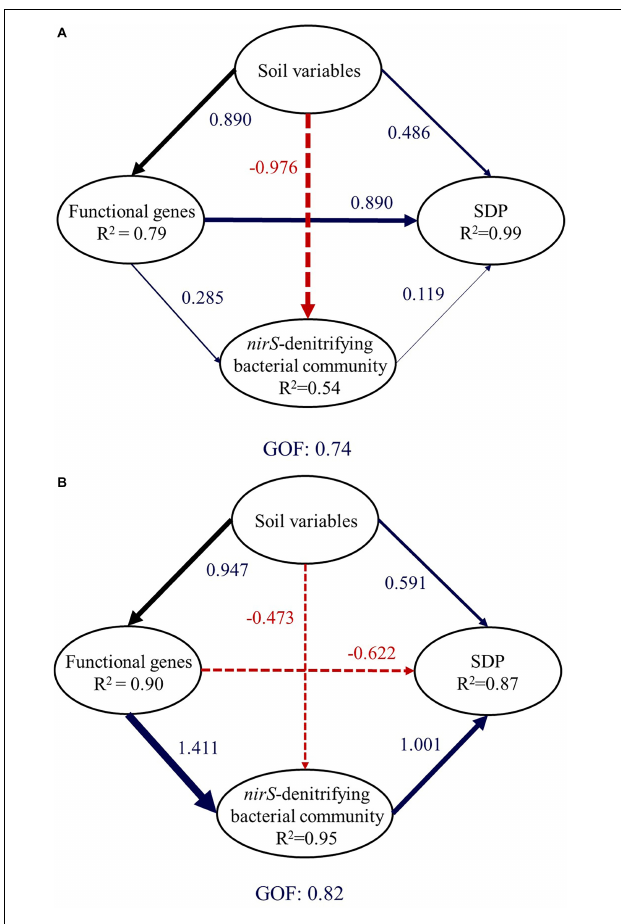
FIGURE 5 | Directed graph of the partial least squares path model for paddy soil (A) and upland soil (B) . Larger path coefficients are reflected in the width of the arrow, with blue indicating a positive effect, and red, a negative effect. Path coefficients are calculated after 1,000 bootstraps. The model is assessed using the goodness-of-fit statistic, a measure of the overall prediction performance. (For interpretation of the references to color in this figure legend, the reader is referred to the web version of this